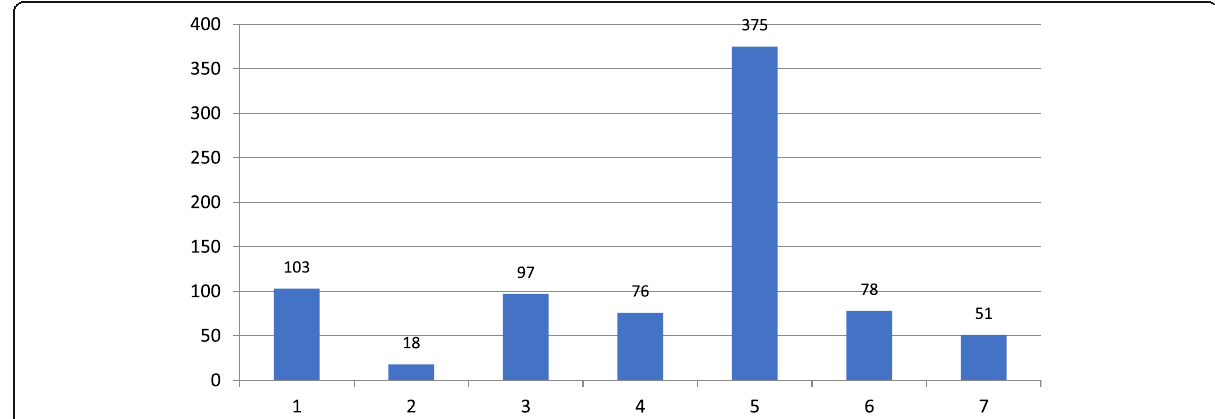
Fig. 11 Frequencies of publications ’ research topic distributions. (Note: 1=K-12 teaching, teacher and teacher education; 2=Post-secondary teacher and teaching; 3=K-12 STEM learner, learning, and learning environment; 4=Post-secondary STEM learner, learning, and learning environments; 5=Goals and policy, curriculum, evaluation, and assessment (including literature review); 6=Culture, social, and gender issues;